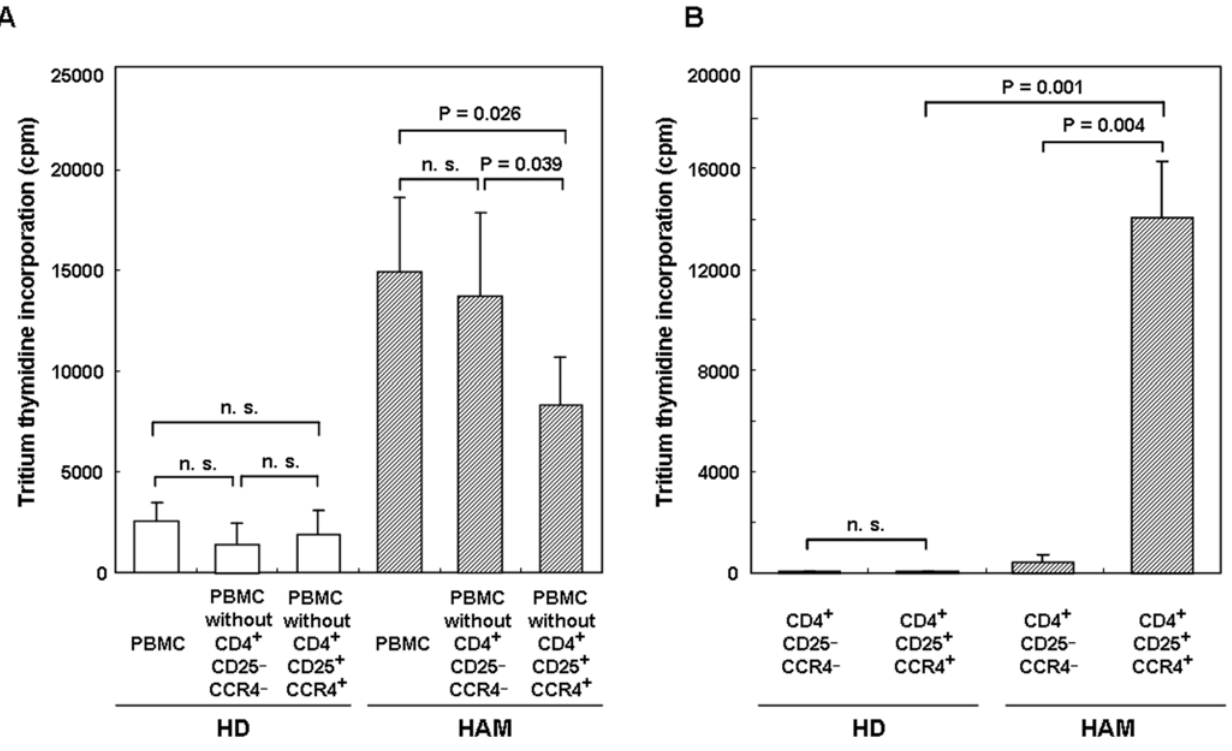
Figure 8. Removal of CD4 + CD25 + CCR4 + T cells decreases spontaneous proliferation of PBMCs from HAM/TSP patients. A. PBMCs, PBMC lacking CD4 + CD25 + CCR4 + , and PBMCs lacking CD4 + CD25 2 CCR4 2 obtained using FACS sorting from 4 HDs and 4 HAM/TSP patients were cultured for 7 days, and the magnitude of proliferation was compared. Data are presented as mean 6 SE. The P values are calculated by paired t test. n.s. not significant. B. CD4 + CD25 + CCR4 + T cells of HAM/TSP patients proliferated independently. CD4 + CD25 + CCR4 + cells and CD4 + CD25 2 CCR4 2 T cells were separated by FACS sorting from 4 HDs and 4 HAM/TSP patients, cultured for 7 days, and the magnitude of proliferation was compared. Data are presented as mean 6 SE. The P values within each group are calculated by paired t test and those between the HD and HAM groups, by unpaired Student’s t test. n.s. not significant.